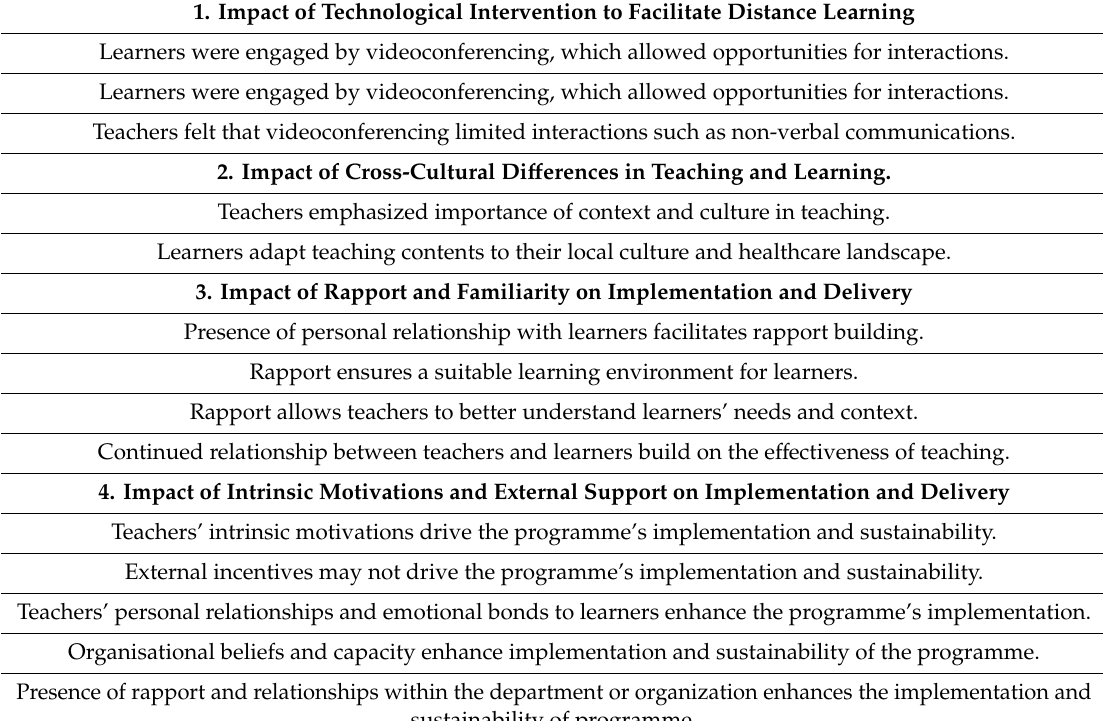
Table 1. Enablers and barriers to tele-teaching programme’s implementation and